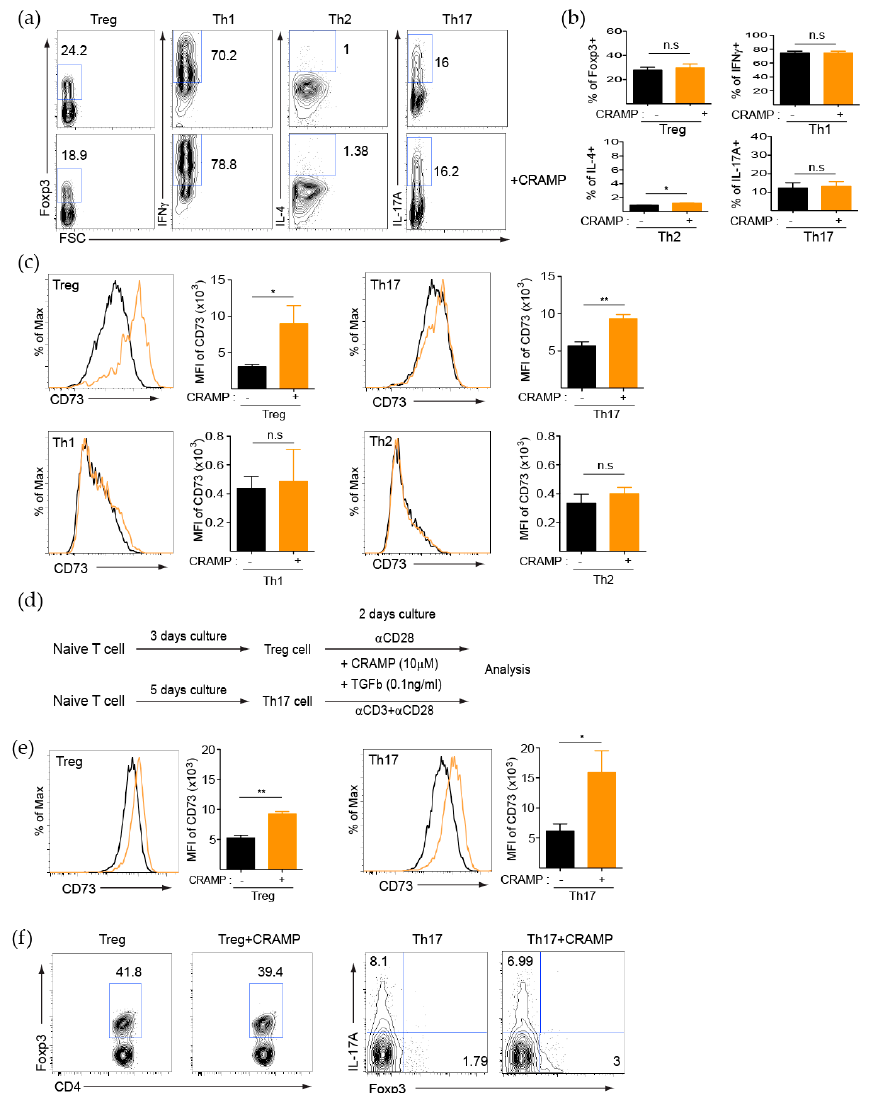
Figure 2. CRAMP induces CD73 expression on CD4 + T cells. ( a – c ) Naïve CD4 + T cells were cultured under each differentiation condition with or without CRAMP (10 μ M) for three days (Th1, Th2, and Treg cells) or five days (Th17 cells). Each in vitro-differentiated subset was stained for their representative markers. Flow cytometry analysis ( a ) and quantification of subsets ( b ) are indicated ( n = 4). ( c ) Flow cytometry analysis of CD73 expression for each subset; the bar graph indicates the mean fluorescent intensity (MFI) value of CD73 ( n = 4). ( d – f ) In vitro-differentiated Treg or Th17 cells were stimulated for two days more with or without CRAMP. ( d ) Experimental scheme of Treg or Th17 cells stimulation for two days with CRAMP. ( e ) Flow cytometry analysis of CD73 expression; the bar graph indicates the MFI value of CD73 ( n = 3). ( f ) Flow cytometry analysis of cellular FoxP3 expression level. A representative result from three independent experiments is shown. * p < 0.05, ** p < 0.01, n.s—not significant (Student’s t